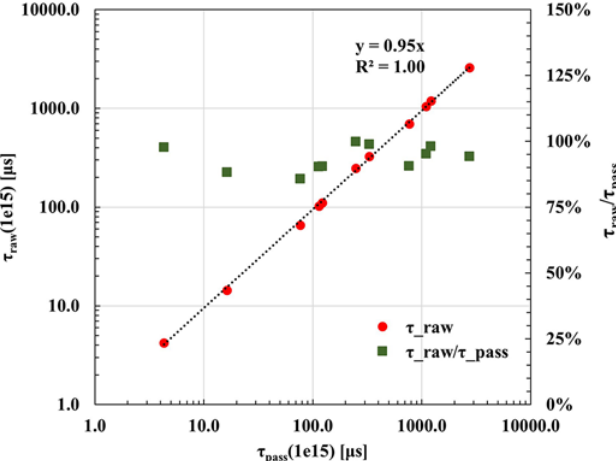
Fig. 8. Excellent correlation found between the lifetime values measured at as-sliced and passivated surfaces at D n =10 15 cm (cid:1) 3 injection level in the whole lifetime range of interest. The smallest lifetime sample are compared at D n =10 14 cm (cid:1) 3 .